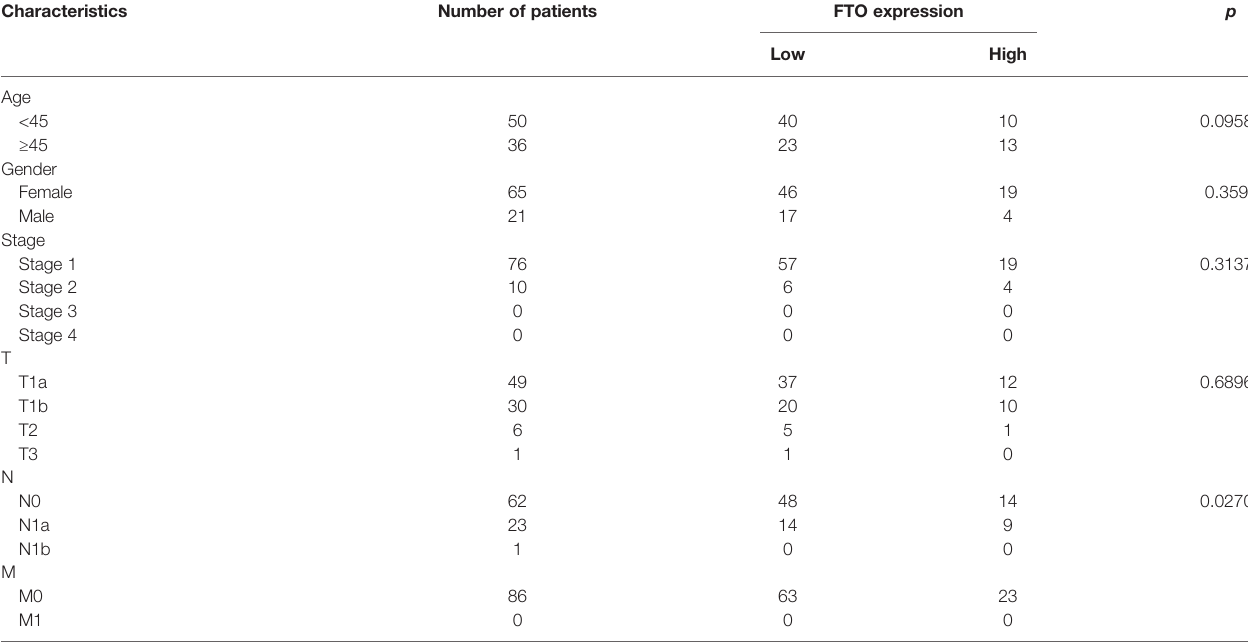
P <0.05 indicates a signi fi cant relationship among the